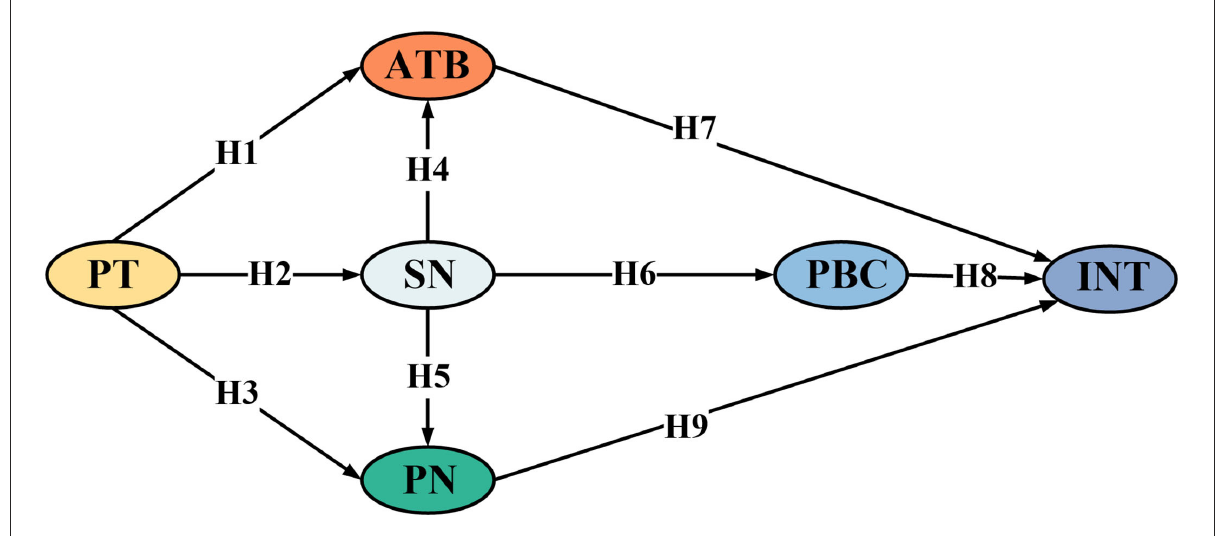
FIGURE1 Theoretical hypothesis